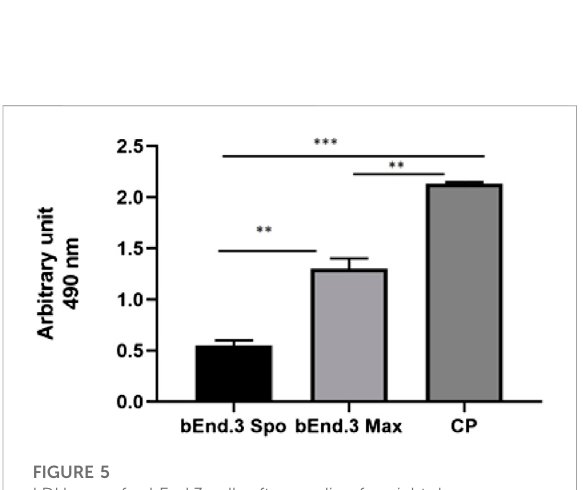
FIGURE 6 Spectro fl uorometric analysis of rhodaminated PACAP (PACAP-Rho) delivery across the BBB dynamic in vitro model. Functionalizedliposomes andnon-functionalizedliposomeswere loaded with PACAP-Rho and injected in the upper fl ow. The passage beyond the endothelial cell layer was then evaluated by sampling downstream the upper fl ow and the lower fl ow, respectively. Dati